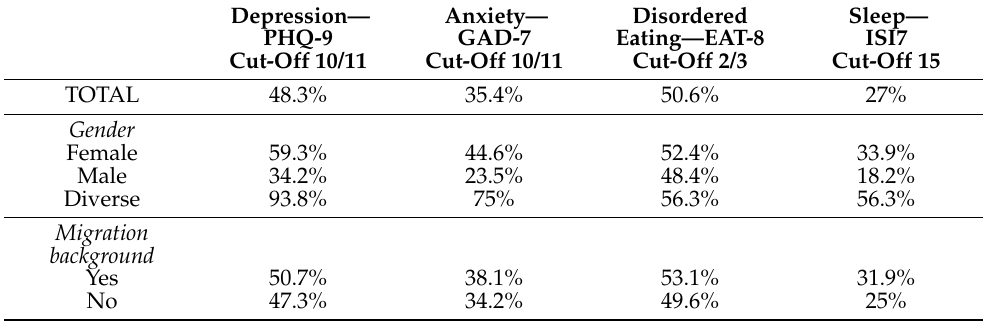
Table 3. Percentage of respondents over the cut-off for clinically relevant mental health disorders according to gender, migration background, and work